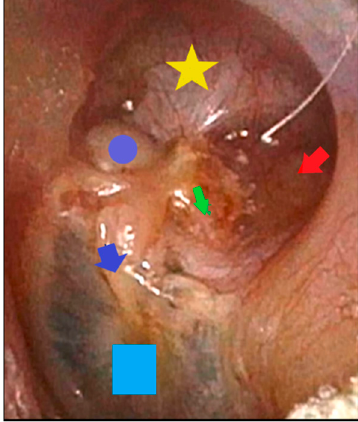
Figure 4. Post-surgical image of AE-AE without ossiculoplasty. Yellow star: atticotomy; blue circle: head of the malleus; blue arrow: handle of the malleus; green arrow: incus; red arrow: antroexclusion with cartilage; blue square: tympanic membrane.